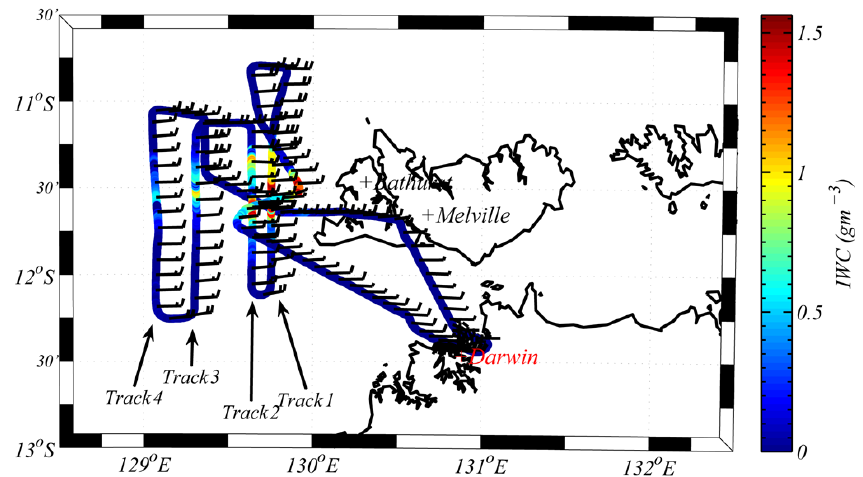
Fig. 1. Cirrus penetration flight tracks 1 to 4 during case study AE13 (on 2005/12/09). The flight track is shown on a map of the Darwin region and Melville and Bathhurst islands in the Beagle Gulf. Darwin city is labelled in red. The aircraft flight tracks are colour coded according to the IWC (gm − 3 ) that was estimated from the CIP probe. Wind-barbs show the wind direction to be easterly and ∼ 15 − 25ms − 1 at the altitude of the aircraft when it was making the cloud penetrations.